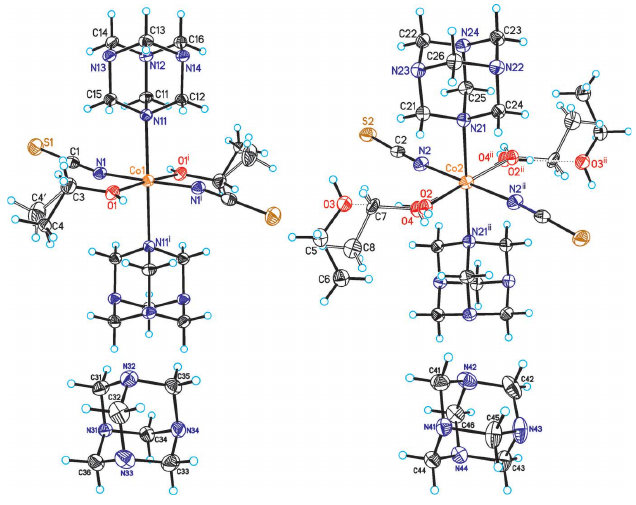
Figure 1 Crystal structure of compound 1 with labelling and displacement ellipsoids drawn at the 50% probability level. Symmetry code for the generation of equivalent atoms: (i) (cid:4) x + 1, (cid:4) y + 1, (cid:4) z + 2; (ii) (cid:4) x + 2, (cid:4) y + 1, (cid:4) z +